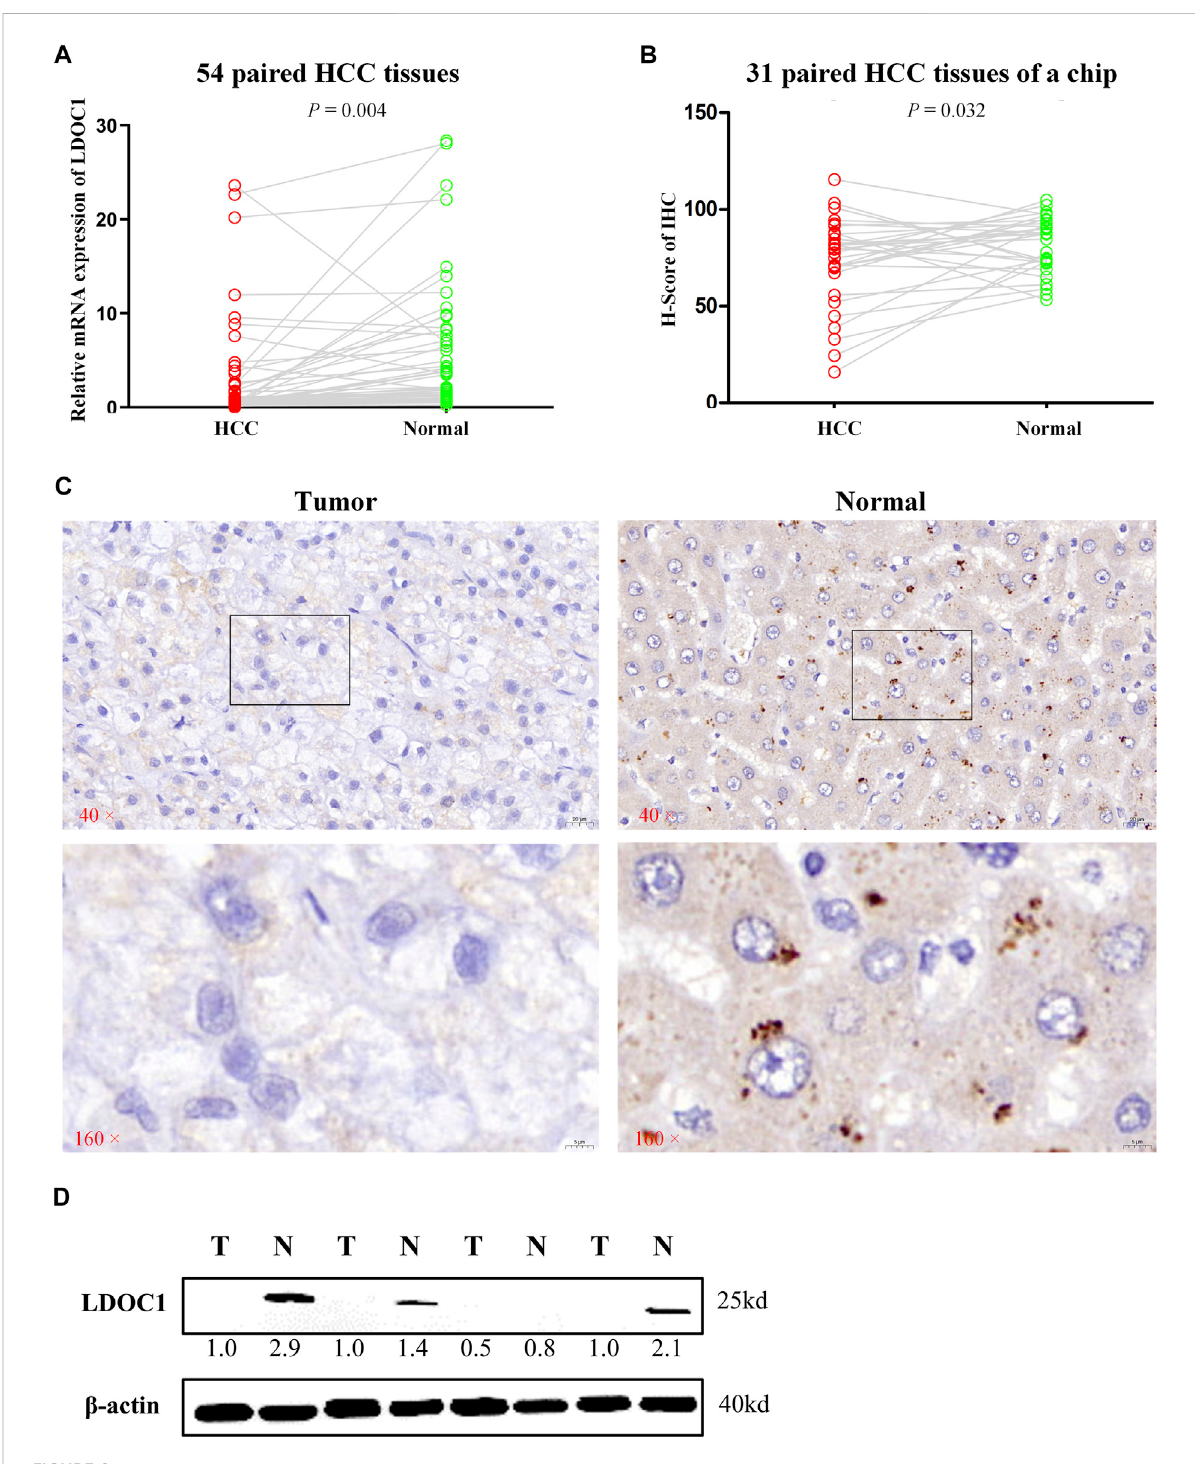
FIGURE 2 Validation experiments of LDOC1 expression. (A) LDOC1 mRNA levels in 54 paired HCC tissues. (B,C) LDOC1 protein levels in 31 paired HCC tissues of a chip via immunohistochemical. (D) LDOC1 protein levels in four paired HCC tissues via Western